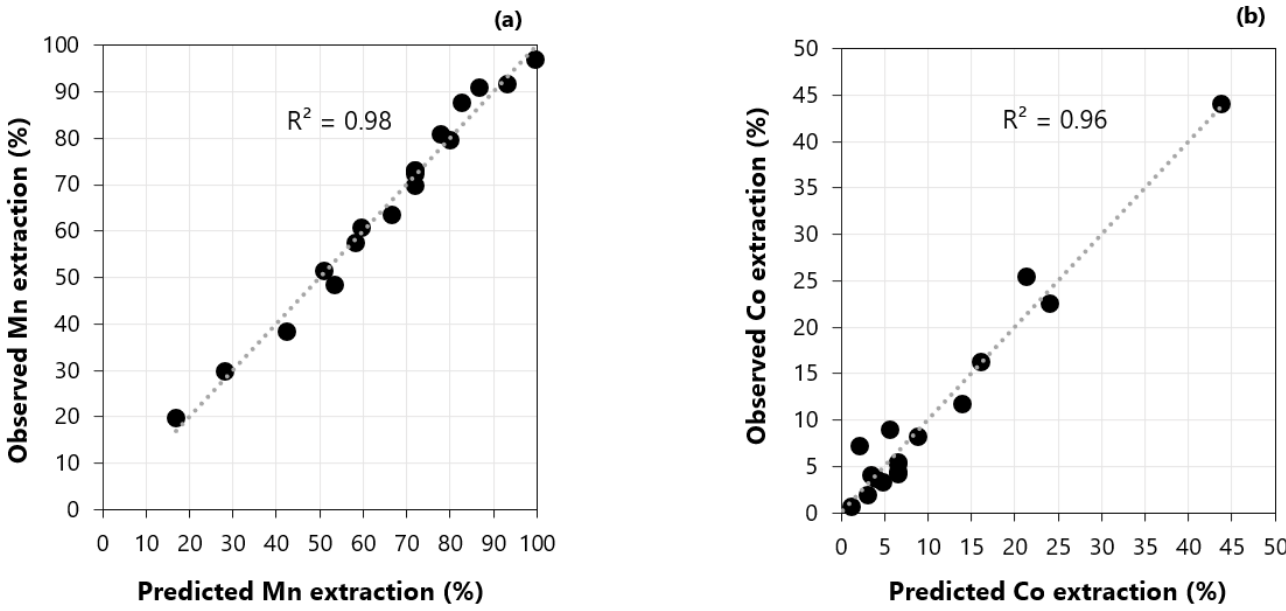
Figure 6. Responses predicted by the model versus experimentally observed: ( a ) manganese extraction and ( b ) cobalt extraction.